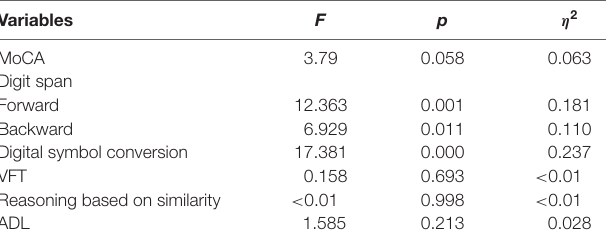
TABLE 2B | Analysis of covariance (ANCOVA) data between cognitive training group and controlled group in T2. Variables